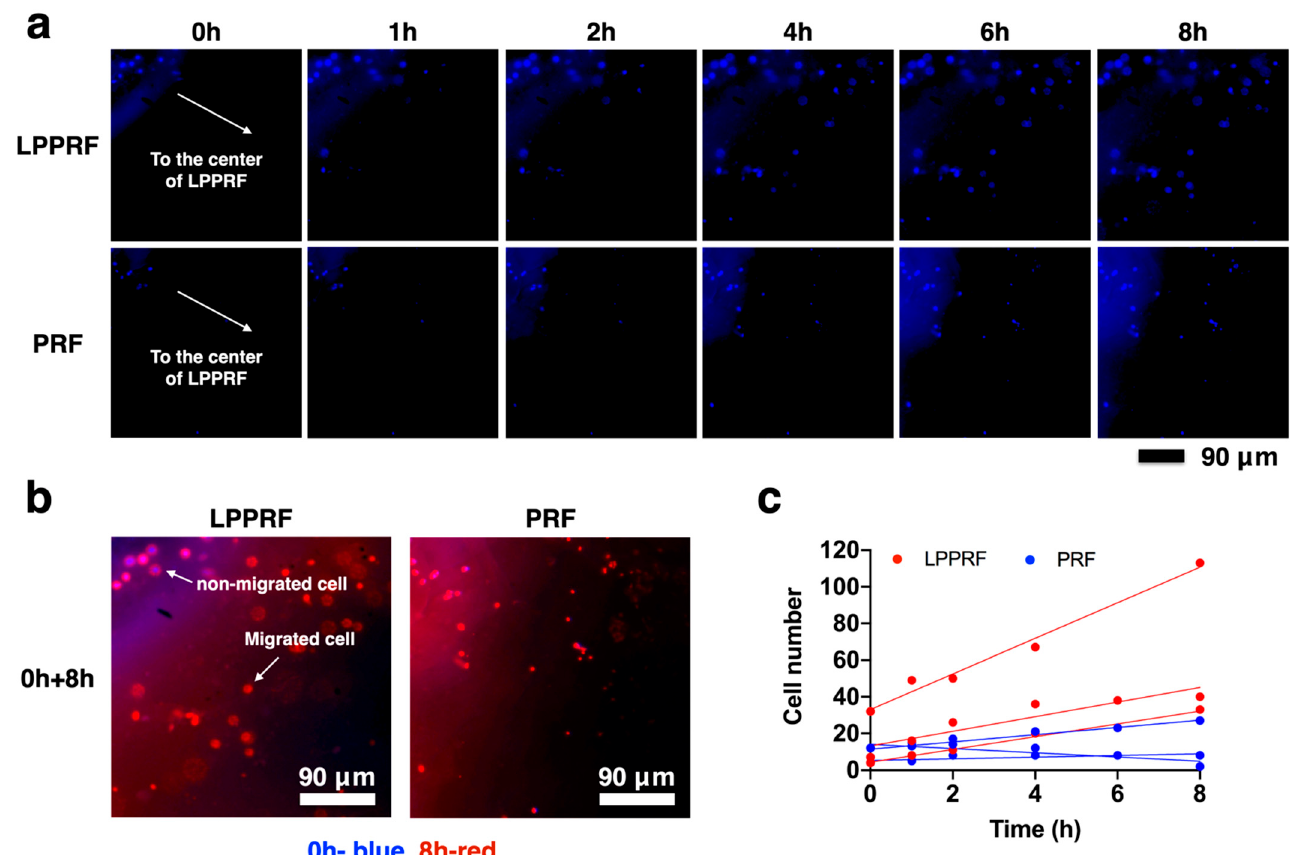
Figure 8. Migration capacity of MC3T3-E1 preosteoblasts cultured in large-pore platelet-rich fibrin membrane and platelet- rich fibrin membrane for 8 h. ( a ) Images of migrated cells stained with Hoechst 33,342 in large-pore platelet-rich fibrin and platelet-rich fibrin at 0, 1, 2, 4, 6 and 8 h after seeding, ( b ) Combination of the images obtained at 0 and 8 h showing cell migration in large-pore platelet-rich fibrin and platelet-rich fibrin and ( c ) Number of migrated cells against time.